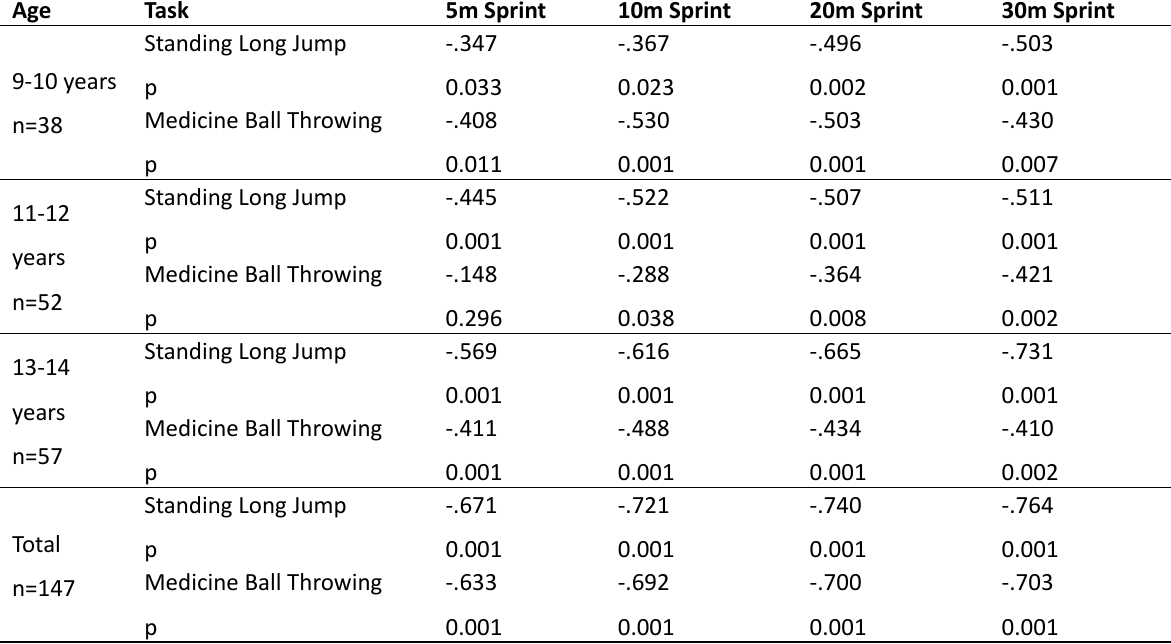
Table 2. The correlation coefficients between sprint speed, standing long jump and medicine ball throwing performance. Age